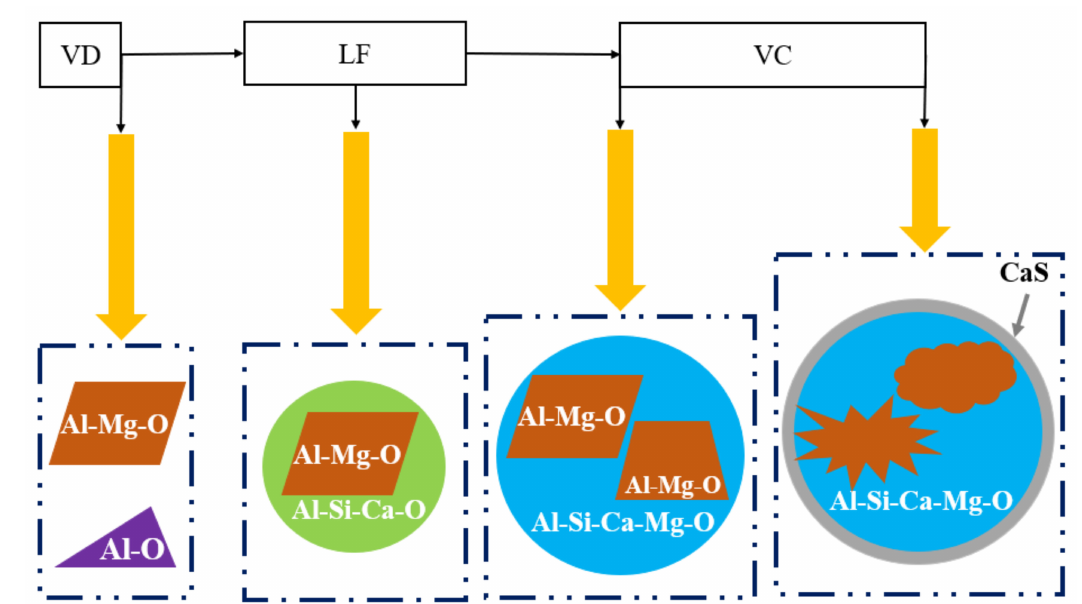
Figure 9. DS-type inclusion evolution diagram with refining